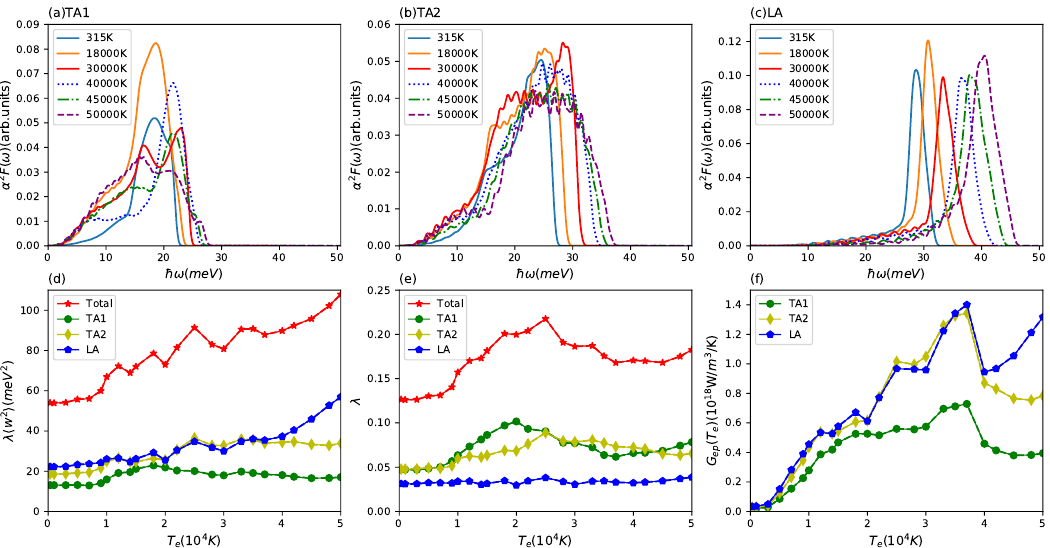
Figure 6. Results for copper. Eliashberg function α 2 F ( ω ) of partial branches of ( a ) TA1, ( b ) TA2 and ( c ) LA at different electron temperatures; ( d ) second moment of Eliashberg function λ (cid:104) w 2 (cid:105) and ( e ) electron–phonon coupling constant λ for total and three different branches (TA1, TA2, LA) with increasing electron temperature; (f) electron temperature-dependent electron–phonon coupling factor G ep ( T e ) for three partial branches (TA1, TA2,